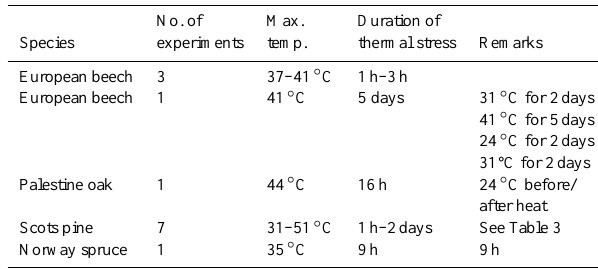
Table 1. Overview of the measurements regarding the impacts of thermal